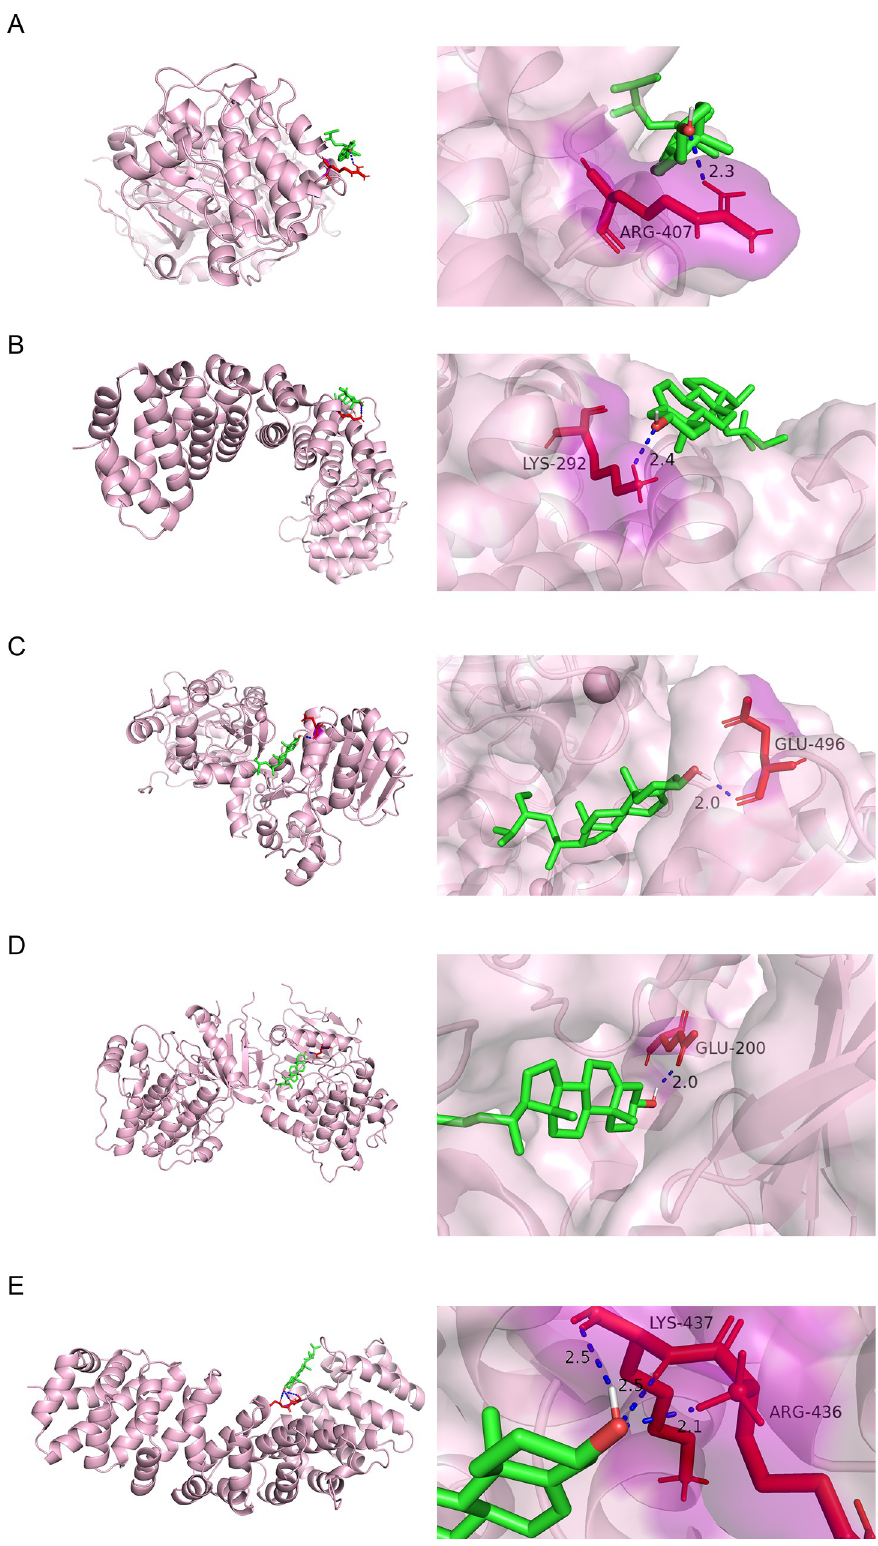
Fig 5. Molecular docking results. (A) Docking results of beta sitosterol targeting AKT2; (B) Docking results of beta sitosterol targeting NFKB1; (C) Docking results of beta sitosterol targeting SIRT1; (D) Docking results of